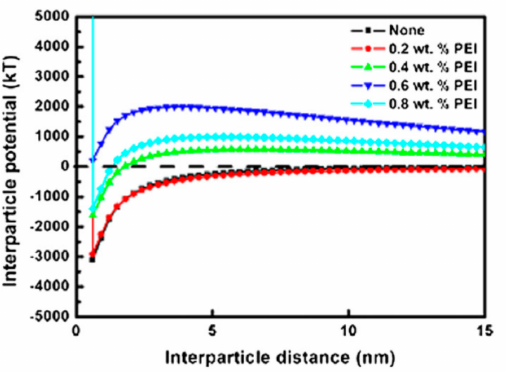
Figure 3. Interparticle interaction calculations for ZrB 2 particles in aqueous medium. Reproduced with permission from [41].